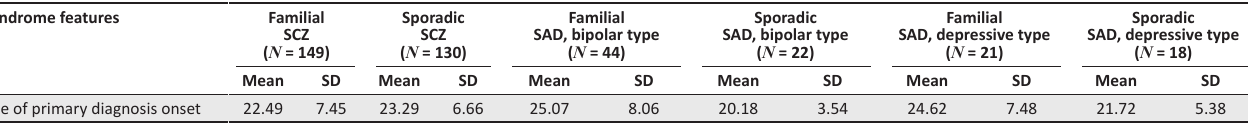
TABLE 1c: Demographic & clinical characteristics of 214 familial and 170 sporadic participants with a DSM diagnosis of schizophrenia or schizoaffective disorder. Syndrome features